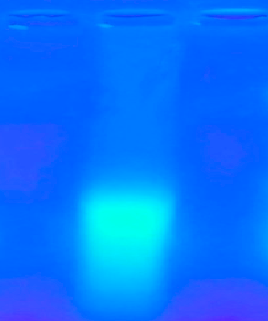
Figure 2. Agarose electrophoresis of fluorescein isothiocyanate-fucoidan (FITC-fucoidan). Table 1. The fucose content and sulfate content of fucoidan before and after being labeled. Content% Fucoidan Before Labeled After Labeled Fucose content 42.86 ± 0.24 45.11 ± 0.88